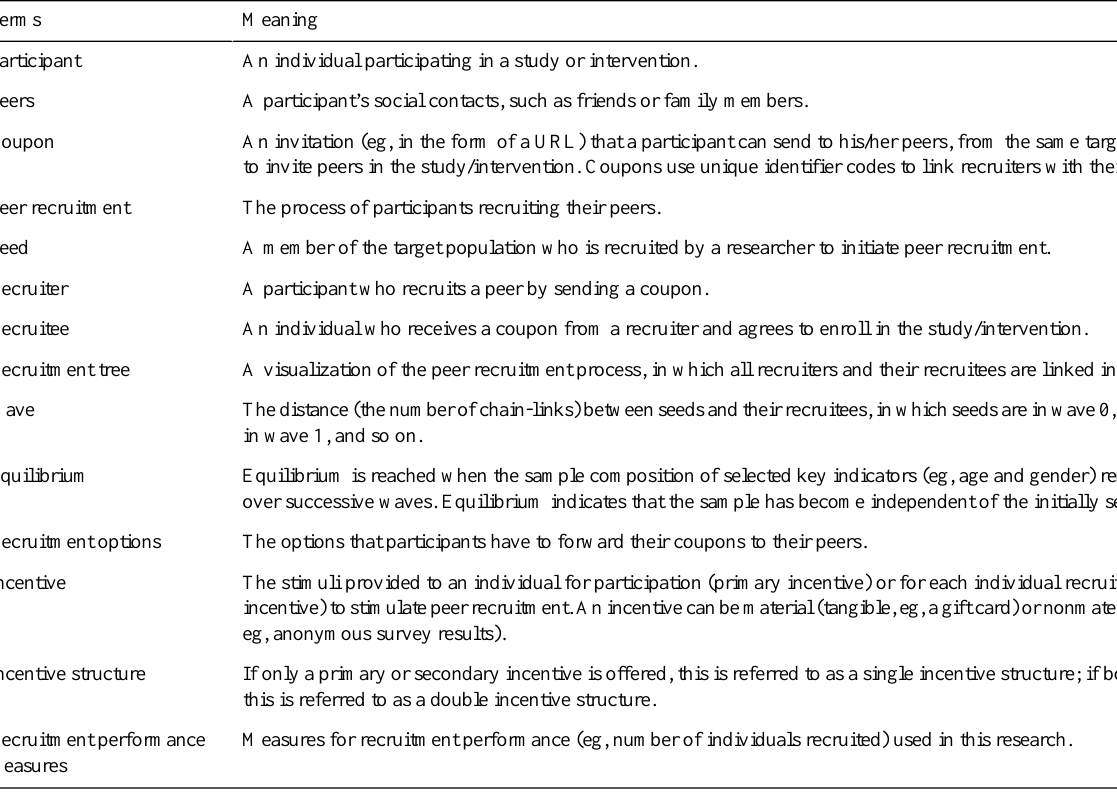
Table 1. Meaning of important web-based RDS terminology. MeaningTerms An individual participating in a study or